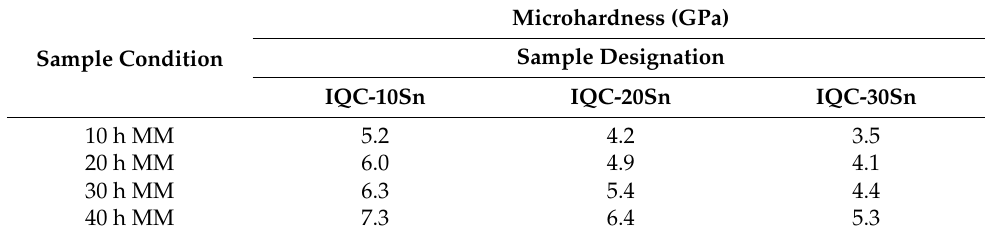
Table 1. Microhardness of IQC-Sn nanocomposite powder samples.